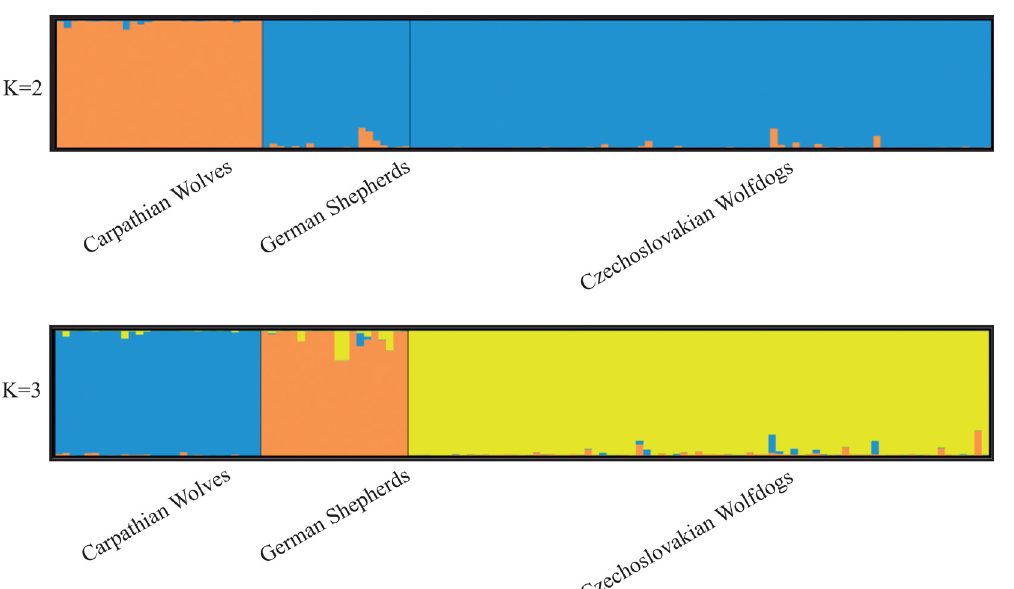
Fig 1. Bayesian clustering analysis of the three populations obtained by STRUCTURE. Each individual is represented by one vertical bar that is divided into segments representing the proportion of memberships to the respective populations. The results are displayed for two ( K = 2) and three ( K = 3) suggested